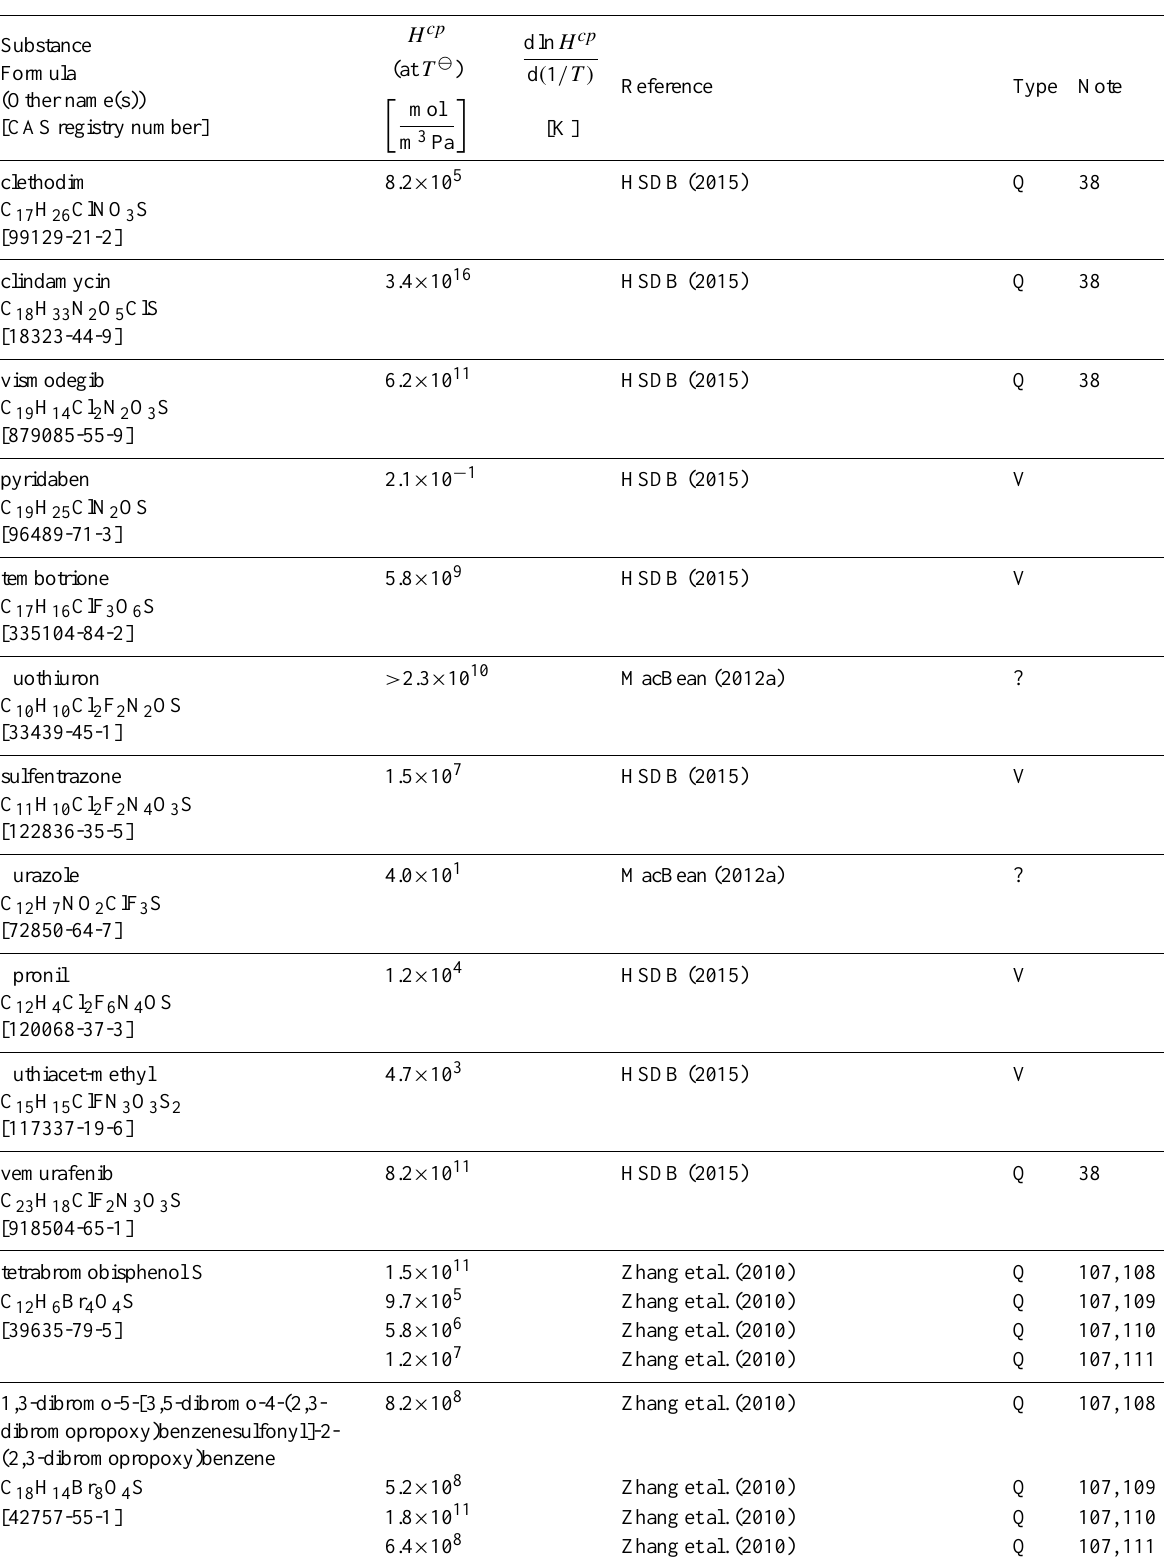
Table 6: Henry’s law constants for water as solvent